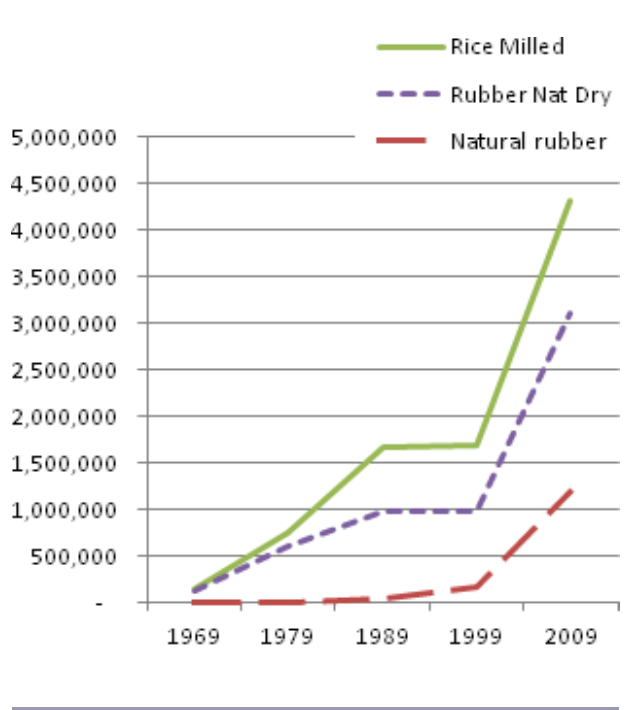
Fig. 3 . Major export commodities of Thailand